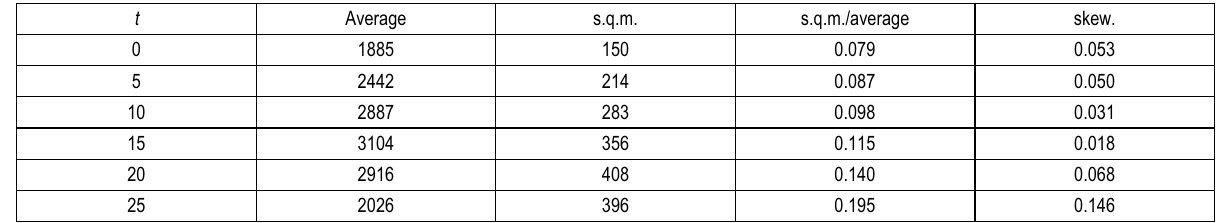
(cid:5) U evidenced for the standard stochasticity level, excluding contract escapes t